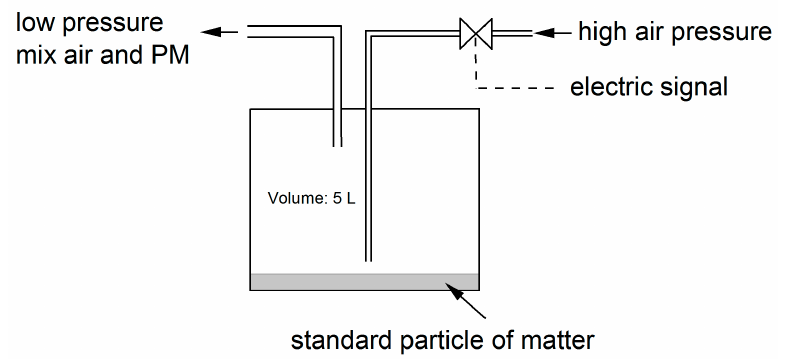
Figure 3. Simplified diagram of the particle matter injector.